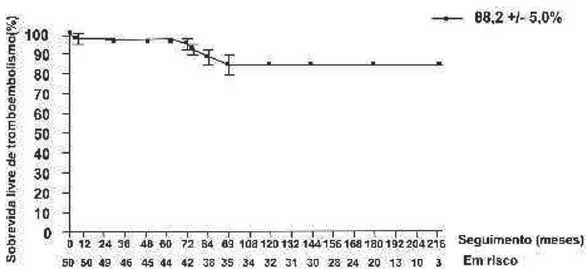
Fig. 1 - Sobrevida actuarial